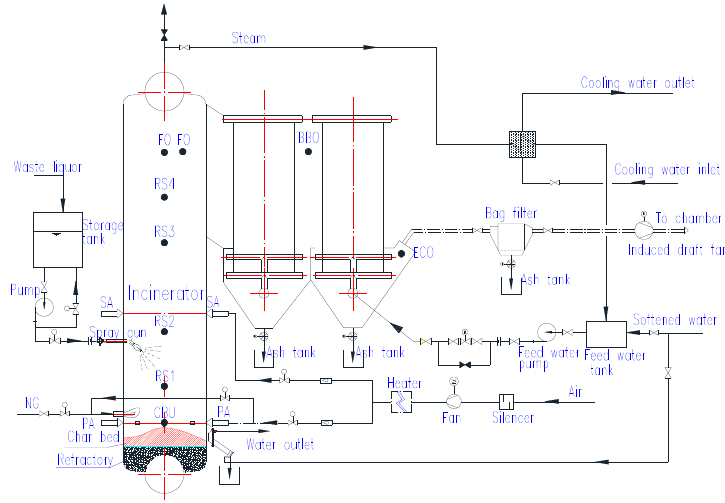
Figure 6. Flowsheet of pilot plant for waste liquor combustion.